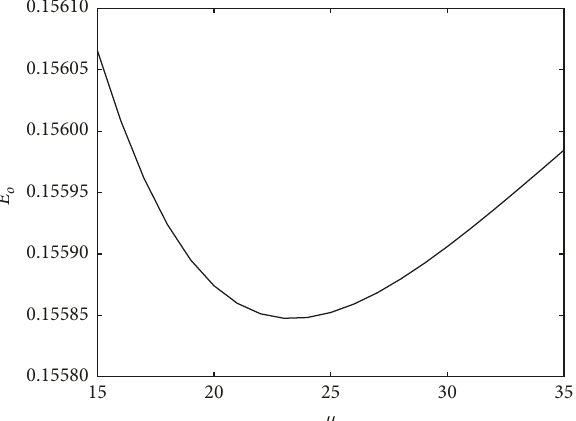
Figure 8: The effect of service rate μ on the mean number of replenishment E